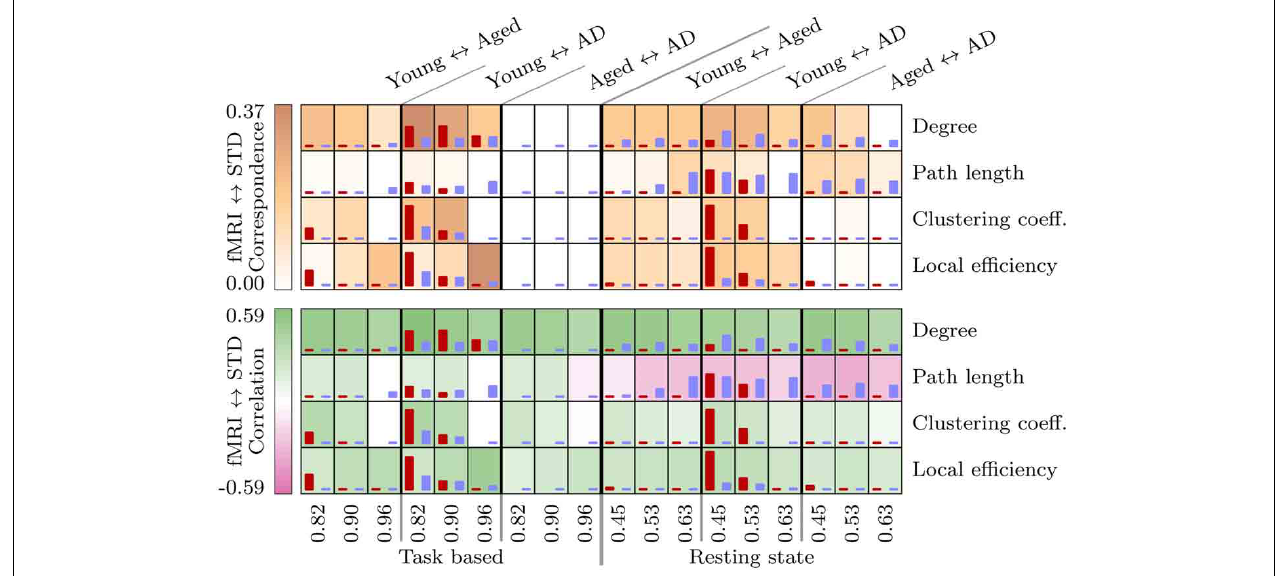
FIGURE 1 | These tables provides a summary of the statistical analysis upon voxelwise network measures between each pair of groups, in the task based and resting state networks. The height of the red and blue bars are proportional to the number of significant voxels found in fMRI and standard space networks respectively, ranging from 0 to a maximum of 3085